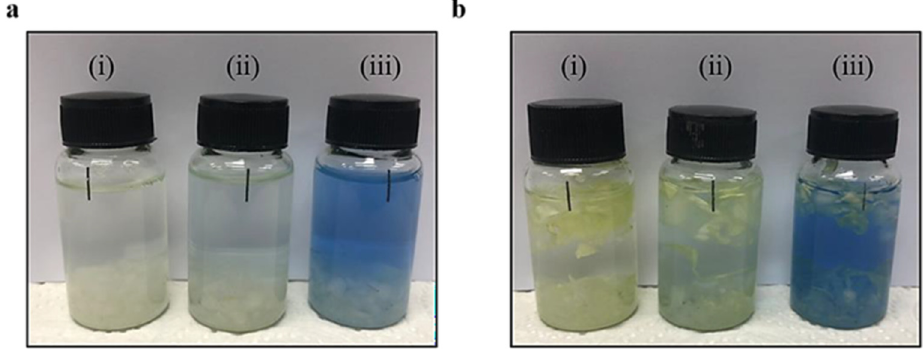
Figure 10. Investigation of paraquat analysis and recovery study using paraquat test kit with online extraction in the reaction cell of ( a ) daikon radish and ( b ) cabbage with (i) nonspiked and spiked standard paraquat at (ii) 0.5 and (iii) 5.0 mg L − 1 .